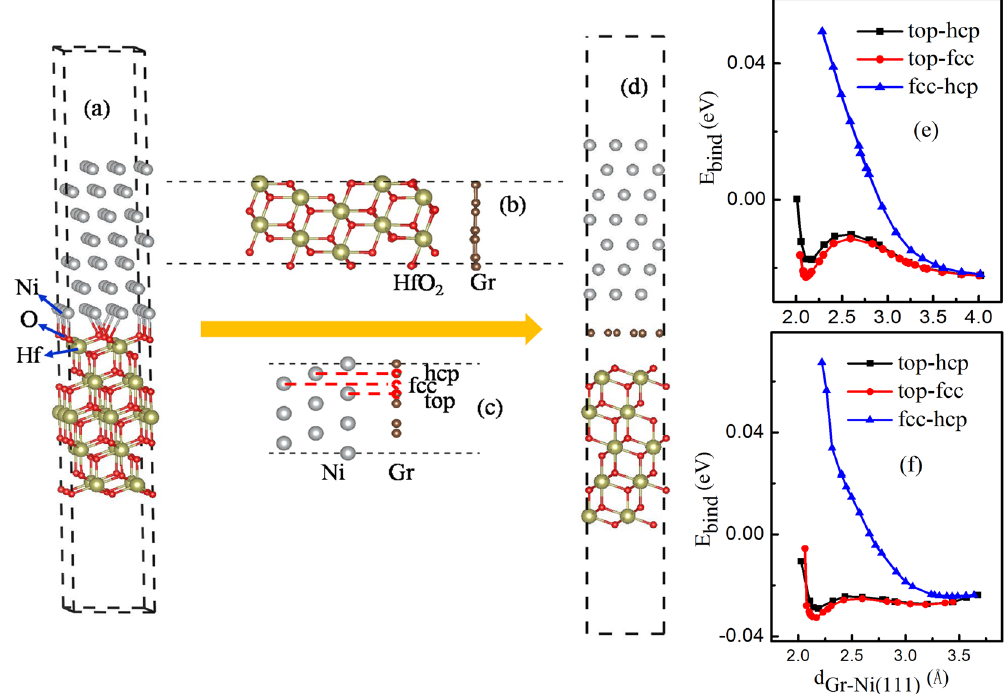
Figure 1. Crystal structure illustrations of supercell for ( a ) Ni(111)/HfO 2 (111), ( b ) Gr/HfO 2 (111), ( c ) Gr/ Ni(111), and ( d ) Ni(111)/Gr/HfO 2 (111) interfaces. Binding energy of Gr/Ni(111) surfaces with graphene adsorption in top-fcc, top-hcp and fcc-hcp configurations vs distance d Gr-Ni(111) calculated with ( e ) PBE, ( f ) optB88-vdW functional. d Gr-Ni(111) is the distance between Gr and Ni(111).